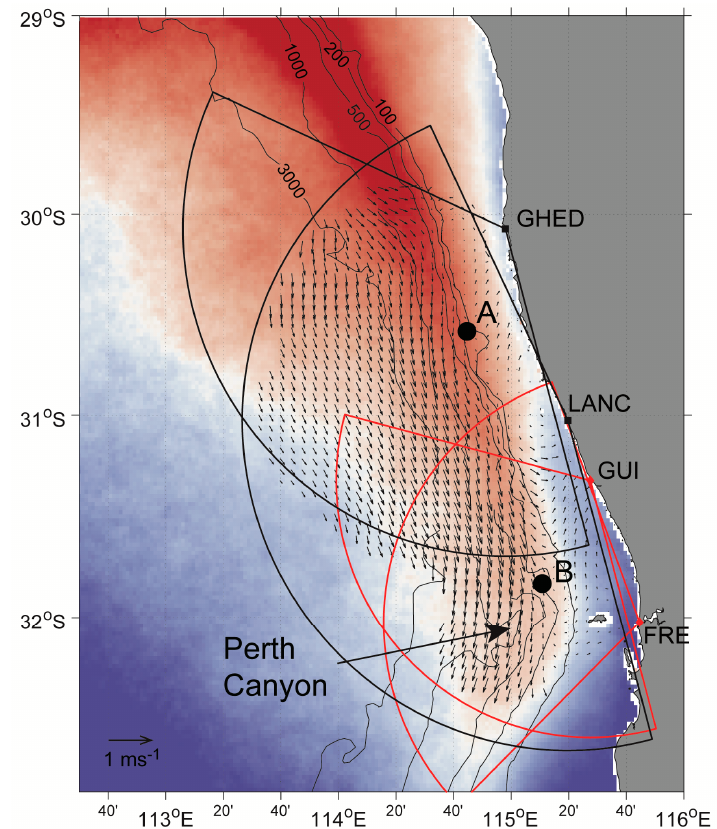
Figure 2. The study region showing the high-frequency radar (HFR) coverage region. Locations marked A and B correspond to the points with maximum data return for the Seasonde ( A ) and WERA ( B ) HFR nodes, respectively. The time averaged HFR currents are overlain on SST data for the